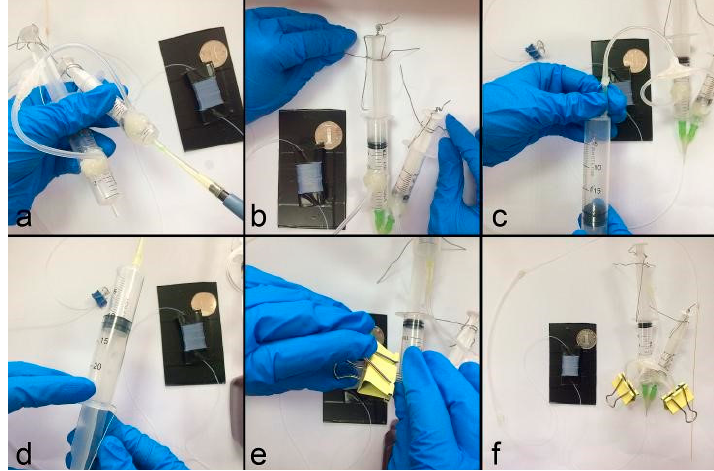
Figure 3. The assembly process for the set-up of the droplet-based continuous-flow on-chip PCR. ( a ) The injection of the liquid and oil phases; ( b , c ) the joint of the device; ( d , e ) pressure setting; ( f ) complete assembly of droplet formation system.